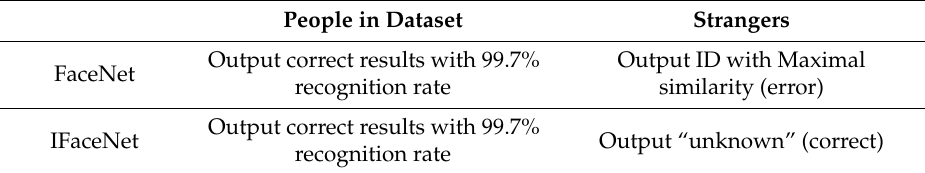
Table 3. Comparison of FaceNet and IFaceNet.